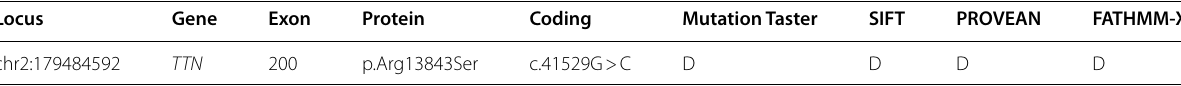
D, damaging or deleterious